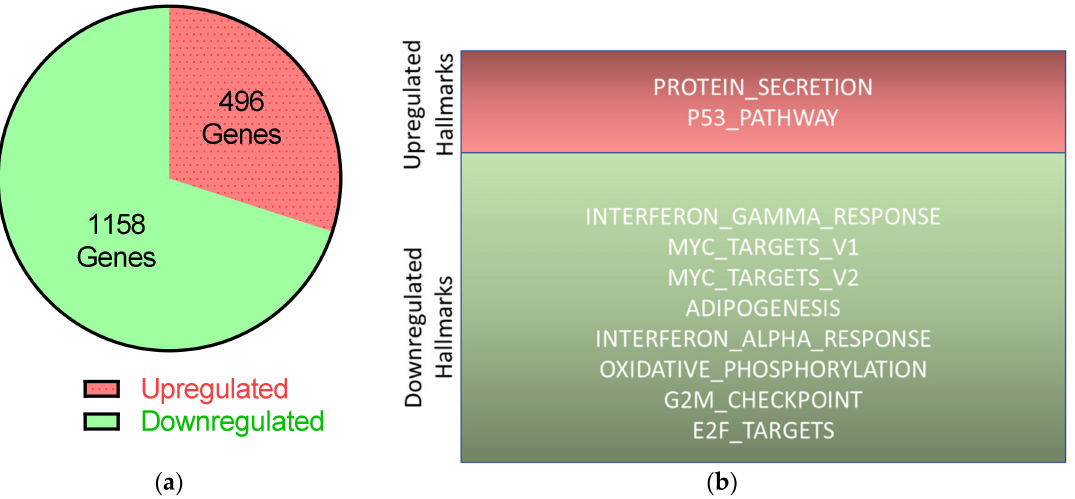
Figure 7. Transcriptional changes in HBLAK after UTX knockdown according to RNA-seq. On day two after transfection of control siRNA or UTX-siRNA 01, RNA was extracted from HBLAK cells and analyzed via RNA-seq. ( a ) Expressions of 496 genes were upregulated; 1158 genes were downregulated following UTX knockdown compared to transfection of control siRNA, with at least 1.5-fold changes and p < 0.05 after Bonferroni correction. ( b ) Results of further analyses of these significantly changed genes using the hallmark gene sets of the GSEA software (Molecular Signatures Database